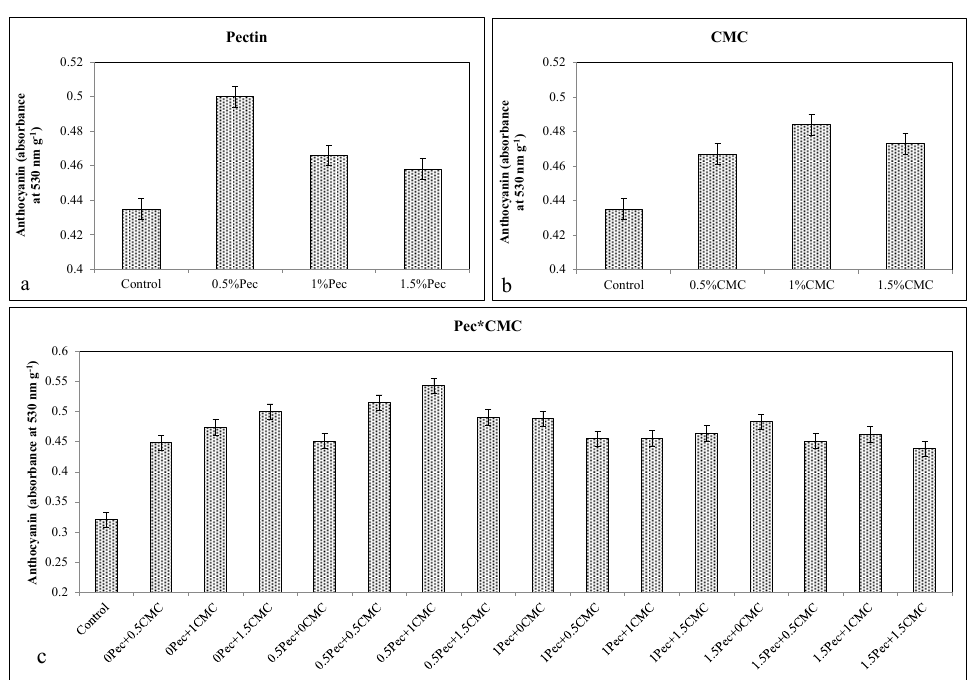
Figure 7. Effect of 0 (control), 0.5 (0.5% Pec), 1 (1% Pec) and 1.5 (1.5% Pec) % pectin-based edible coatings ( a ), 0 (control), 0.5 (0.5% CMC), 1 (1% CMC) and 1.5 (1.5% CMC) % carboxymethylcellulose-based edible coatings ( b ) and their combinations ( c ) on anthocyanin during cold storage period. Data are the “estimated marginal means ±95% confidence intervals”. The results were expressed on a fresh weight basis. The columns with non-overlapping error bars are significantly different ( p ≤ 0.05).